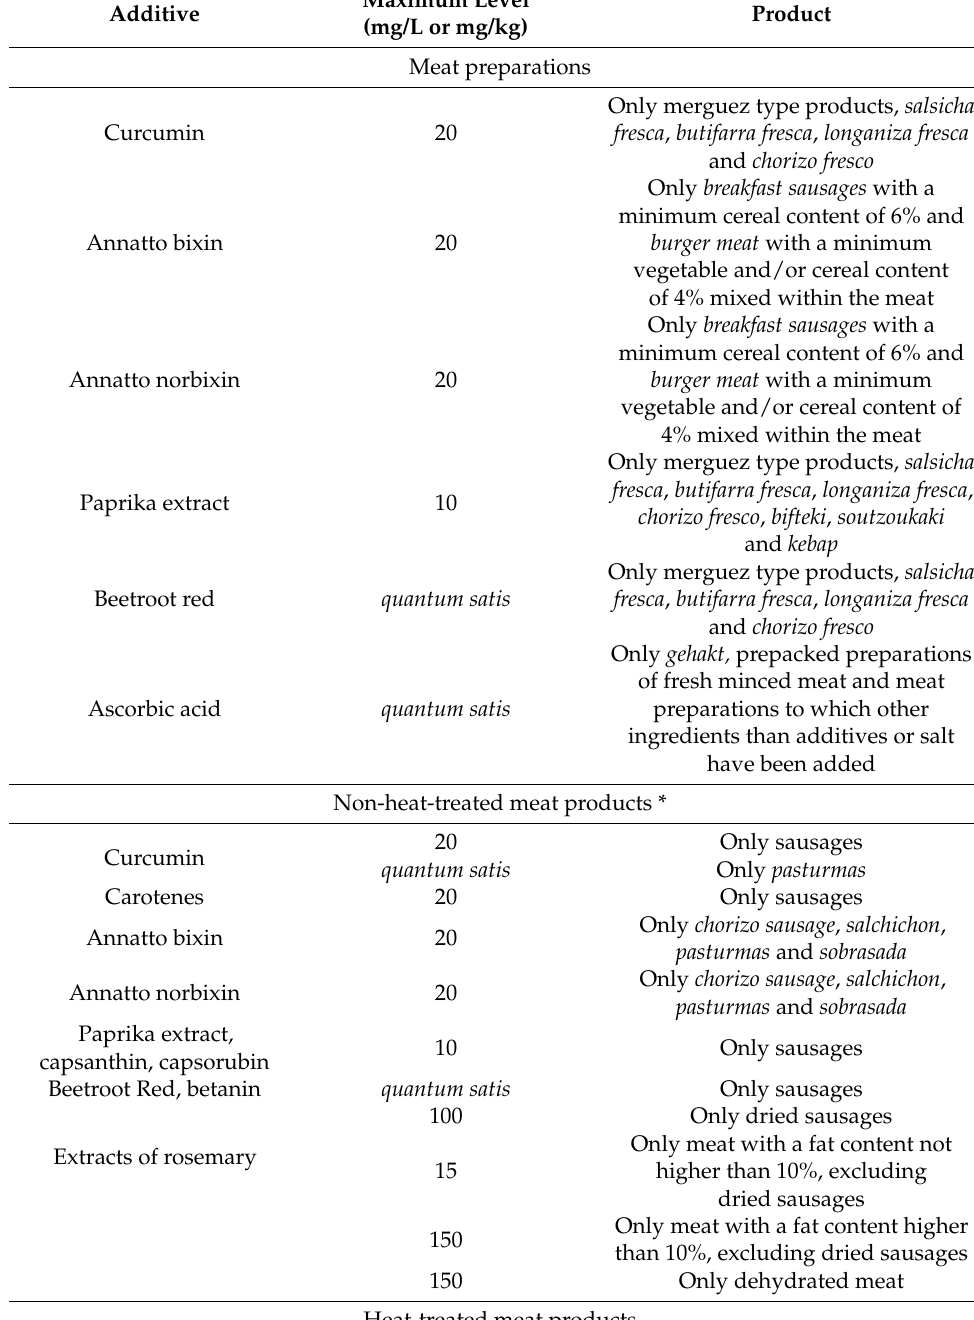
Table 1. Compounds/ingredients obtained from plants allowed for use as food additives in meat products by the EU that could confer antioxidant